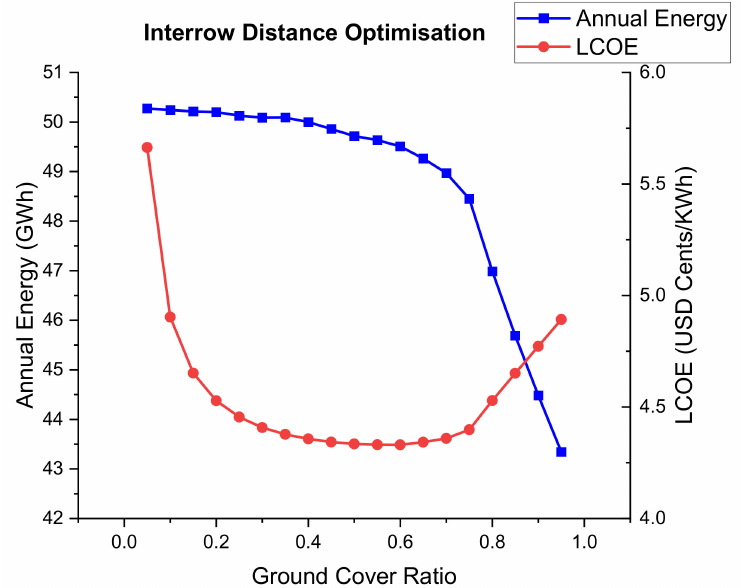
Figure 10. Variation of the annual energy and the LCOE with the Ground Cover